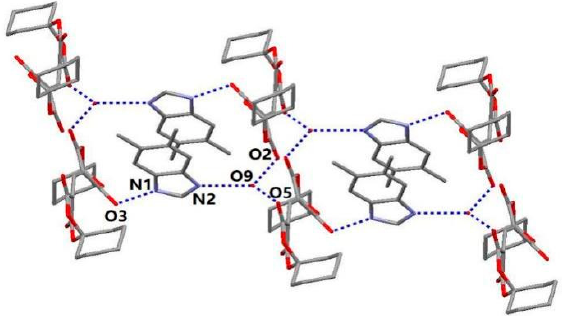
Figure 2. 2D-net structure of DBH. Table 3. N–H···O and O–H···O Molecular Interactions for DBH .